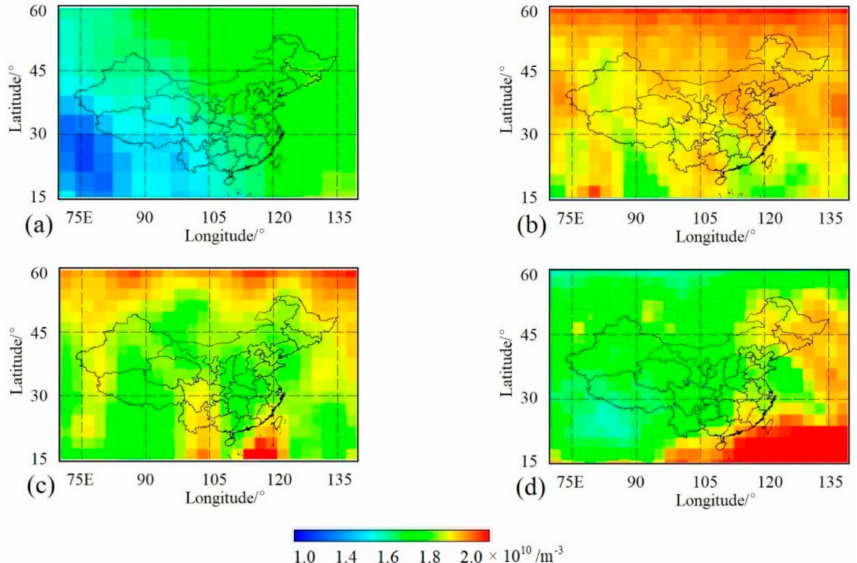
Figure 1. Averaged seasonal variations of O + density for the periods of ( a ) January–March,